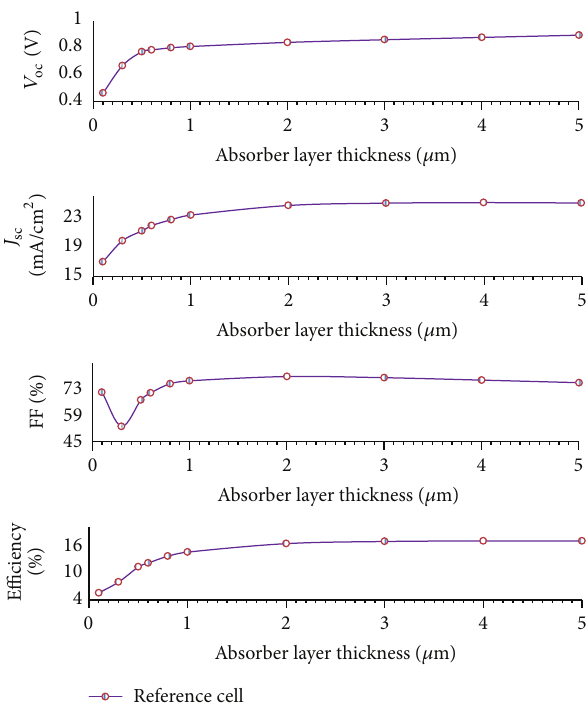
Figure 2: Effect of CdTe thickness layer variation on reference cell parameters and proposed cell parameter.